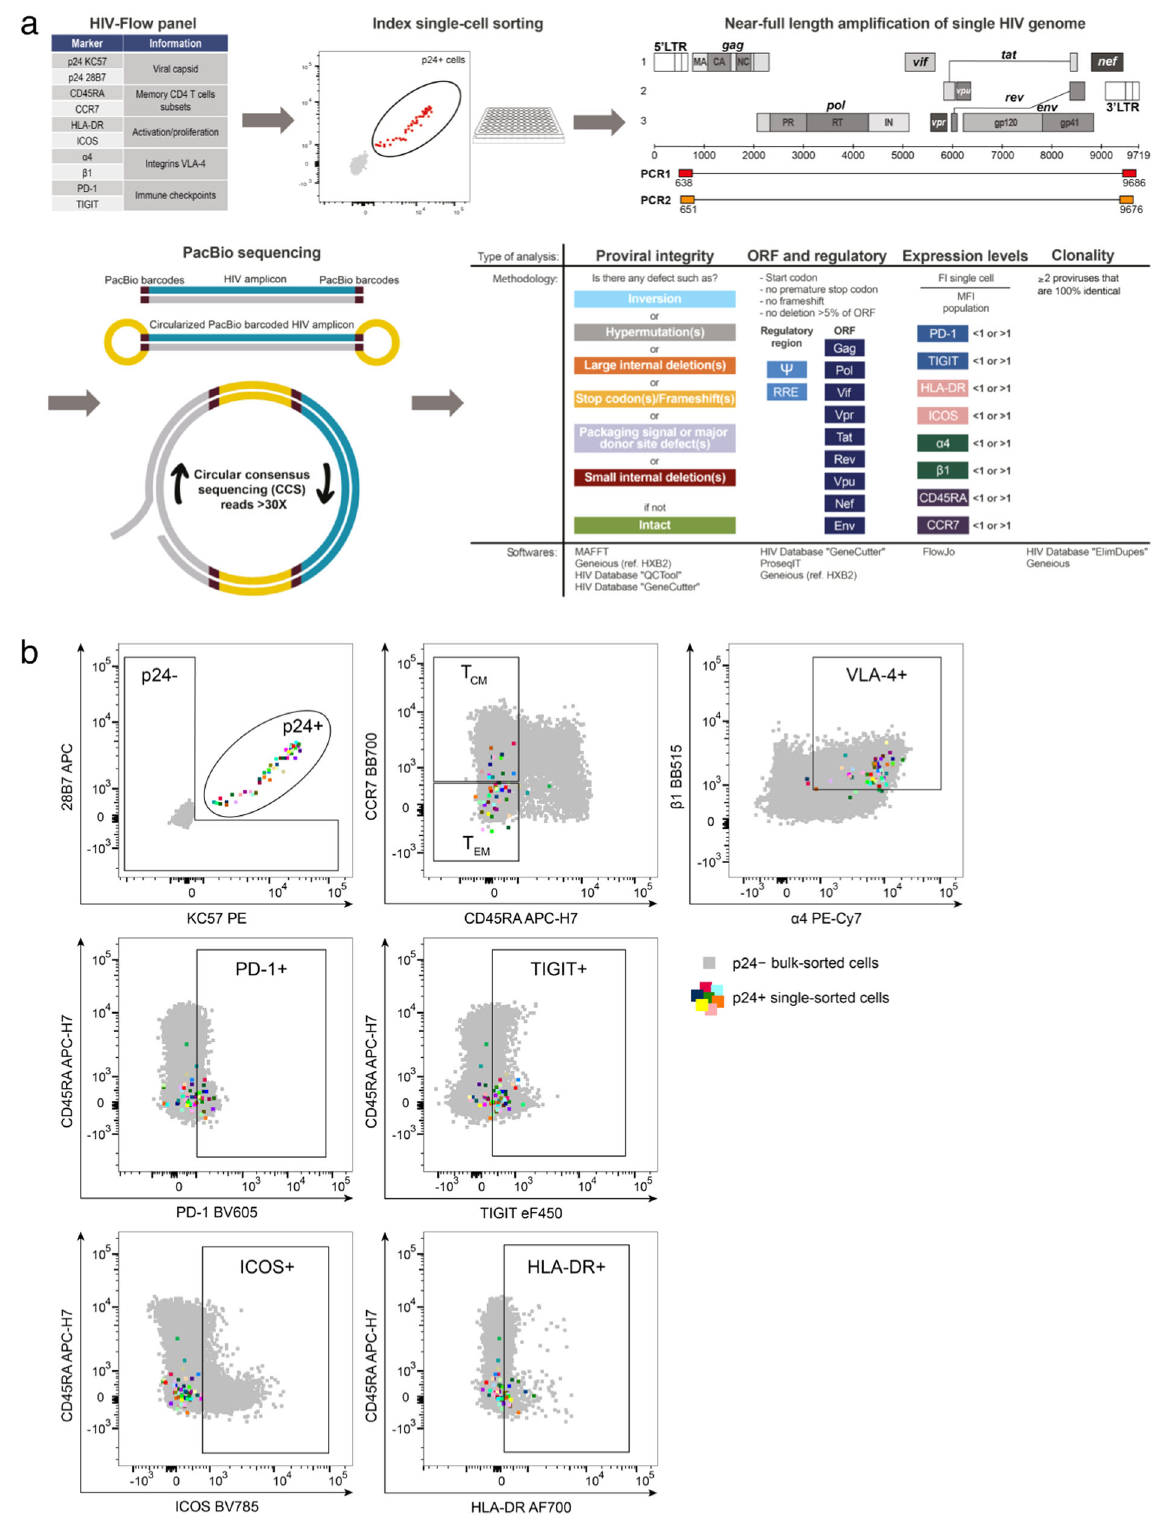
Fig. 1 | Near full-length genome sequencing in single p24-expressing cells. a Isolated CD4+ T cells were stimulated with PMA/ionomycin for 24h in the pre- sence of BFA prior to extracellular and intracellular staining using antibodies speci fi c to the cellular and viral proteins listed in the HIV-Flow panel table. Single p24+ cells were index-cell sorted in individual wells. NFL HIV ampli fi cation by nested PCR was performed on each single sorted p24+ cells, followed by PacBio